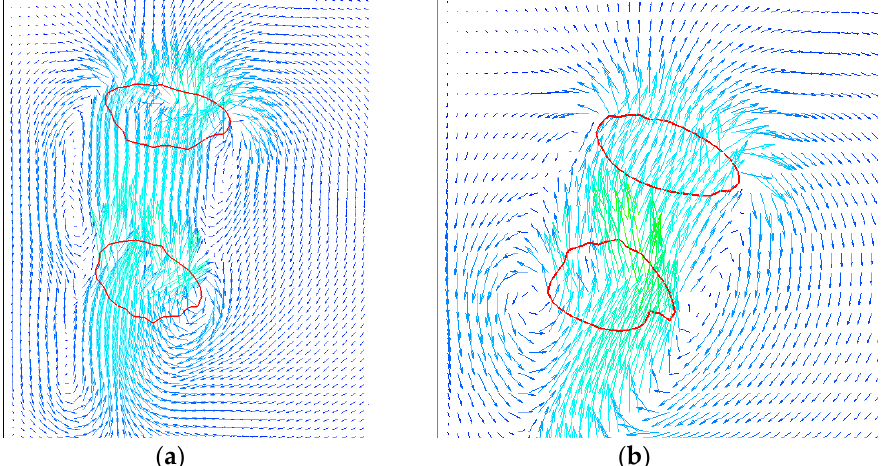
Figure 12. Upward flow field diagrams of vertically arranged double bubbles at different moments: ( a ) 80 ms, ( b ) 110 ms. (2) The upper small and the lower large double bubbles